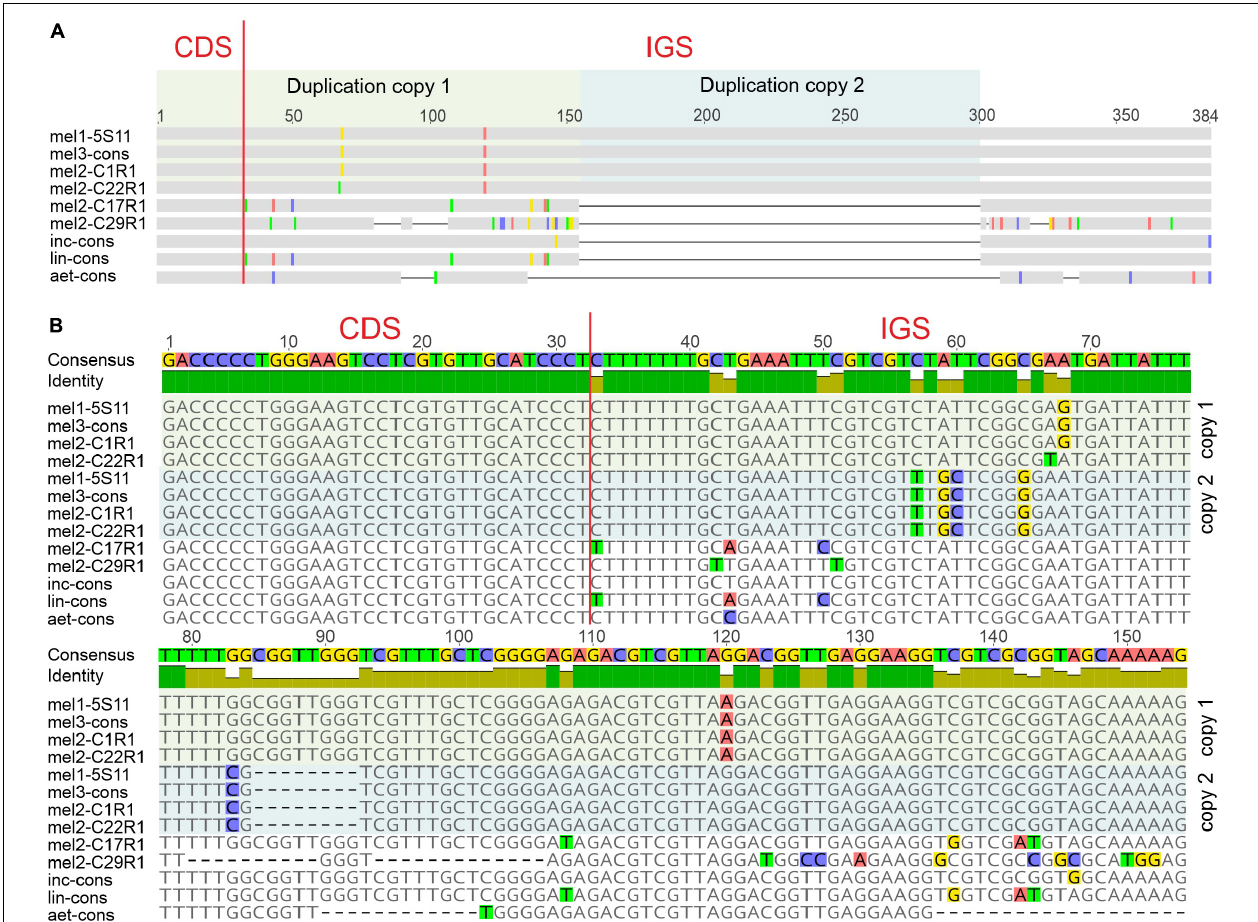
FIGURE 2 | (A) Schematic representation of the molecular organization and (B) sequence alignment of the 3 (cid:48) fragment of the coding sequence (CDS) and the complete intergenic spacer region (IGS) the of 5S rDNA of S. melongena (mel) and closely related species S. aethiopicum (aet), S. incanum (inc), S. linnaeanum (lin). Two copies of duplication are shown separately and highlighted in different colors. Ribotype and clone names are shown after abbreviations of species names; cons, consensus